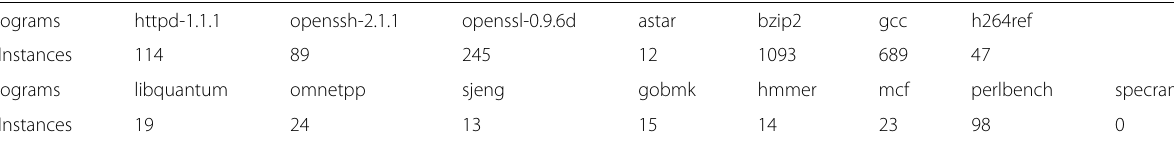
Table 3 The number of randomized data structure instances at runtime